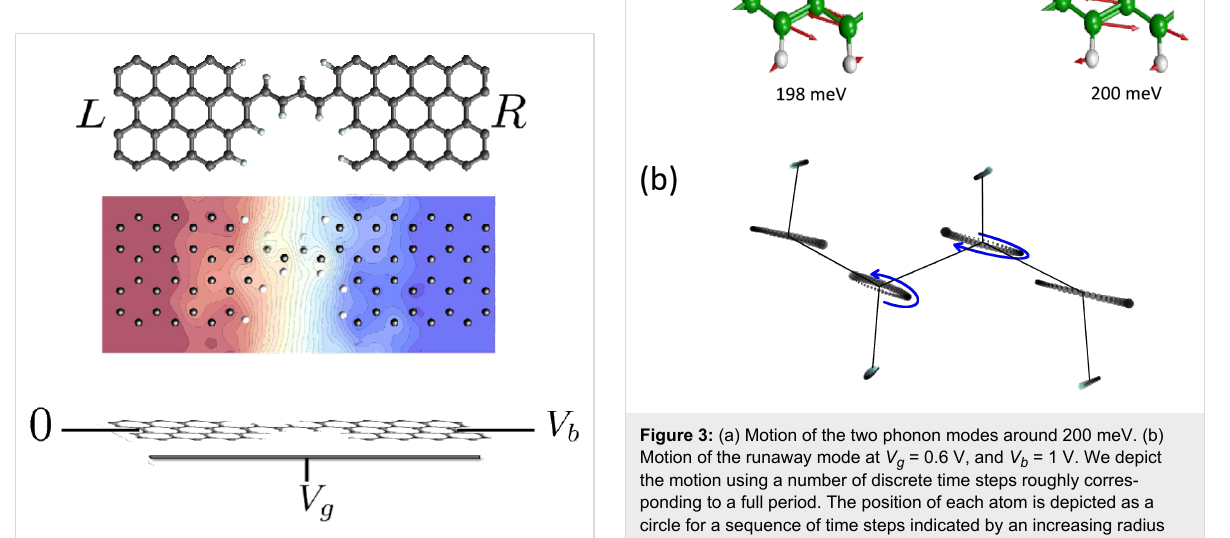
Figure 3: (a) Motion of the two phonon modes around 200 meV. (b) Motion of the runaway mode at V g = 0.6 V, and V b = 1 V. We depict the motion using a number of discrete time steps roughly corres- ponding to a full period. The position of each atom is depicted as a circle for a sequence of time steps indicated by an increasing radius with time. The motion is a phase-shifted linear combination of the two modes in (a). We can see the elliptical motion of the carbon atoms from the plot. The enclosed area indicates that work can be done by the current-induced NC